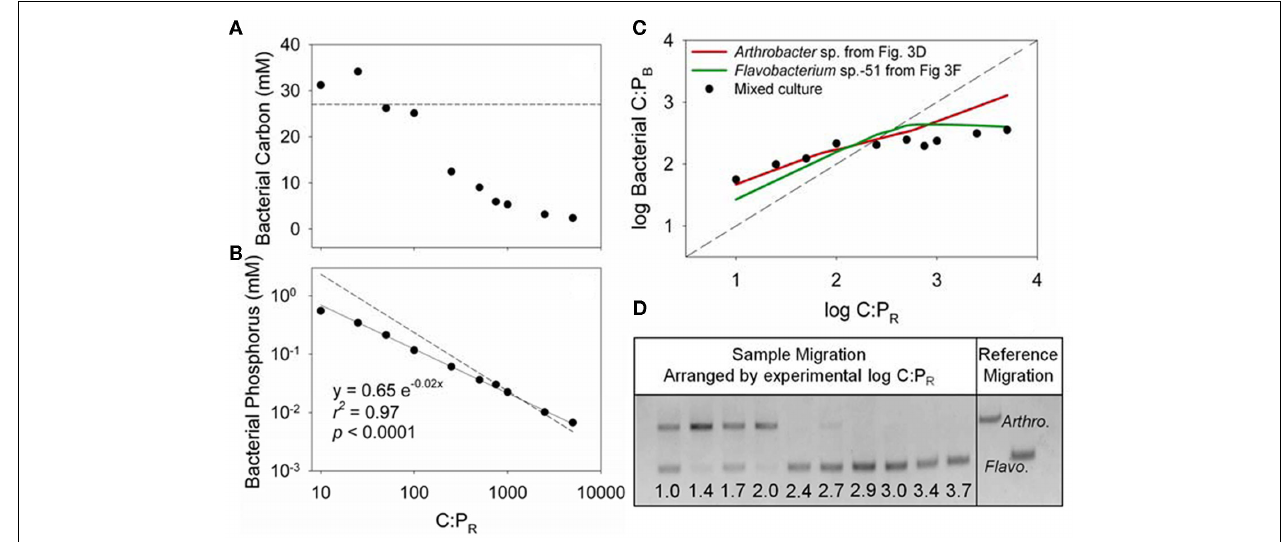
(filled circles) and Arthrobacter sp. (red line) and Flavobacterium sp.-51 (green line) individually. (D) Shows results of amplified ribosomal DNA restriction analysis (ARDRA) for each of the treatments in the mixed-culture experiment and the reference migrations of Arthrobacter sp. and Flavobacterium